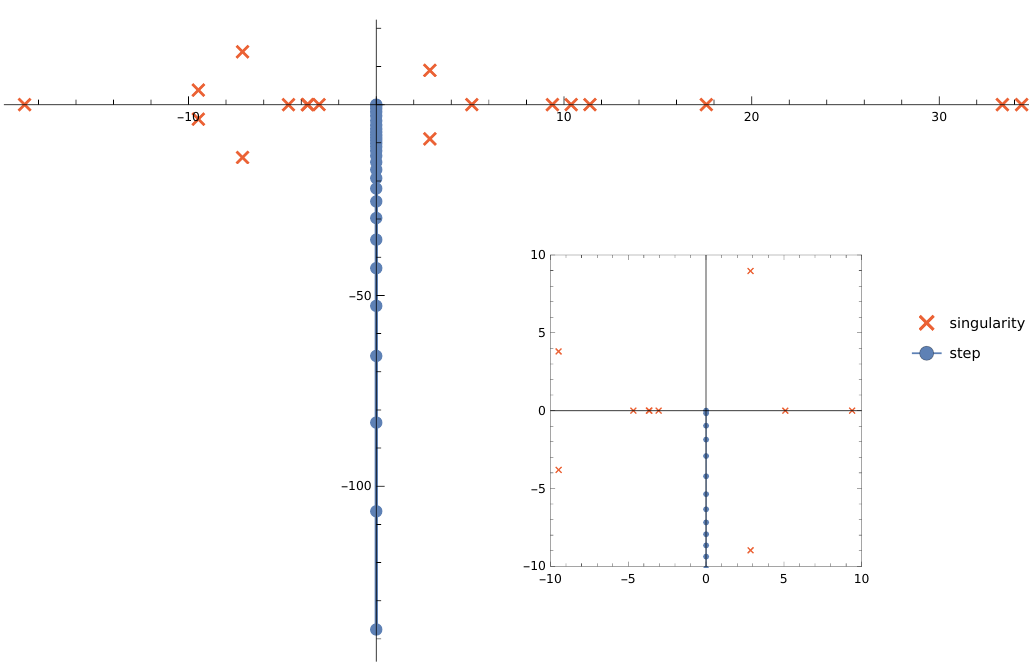
Figure 6. A typical path to solve the differential equation at a certain phase space point. This plot shows singularities and steps of the family planar no. 1 at s = (500 GeV ) 2 , t = − (300 GeV ) 2 in the complex plane of x . The red crosses are the singularities of the differential equation, while the blue dots are the steps used to solve the differential equation. We approach the origin from − i ∞ along the positive imaginary axis. The boundary at x = − i ∞ is not shown on this plot. The smaller plot shows the situation near the physical